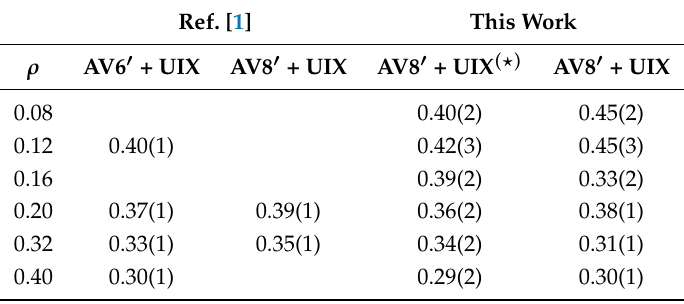
Table 1. Spin susceptibility ratio χ / χ F in PNM at different densities (in fm − 3 ). Results from Ref. [1] using the two-body potentials AV6 (cid:48) and AV8 (cid:48) supported by the three-body force UIX are reported in the second and third columns. The last two columns show the results of this work for the AV8 (cid:48) + UIX potential. AV8 (cid:48) +UIX ( (cid:63) ) indicates the results obtained at the spin polarization of the ground state ξ 0 predicted while using the free FG, to be directly compared with the values reported in Ref. [1]. Ref.